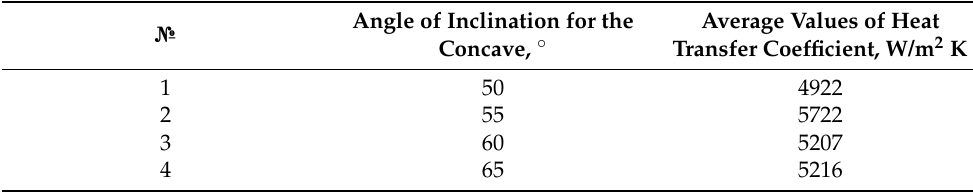
Table 2. Average values of heat transfer coefficient.